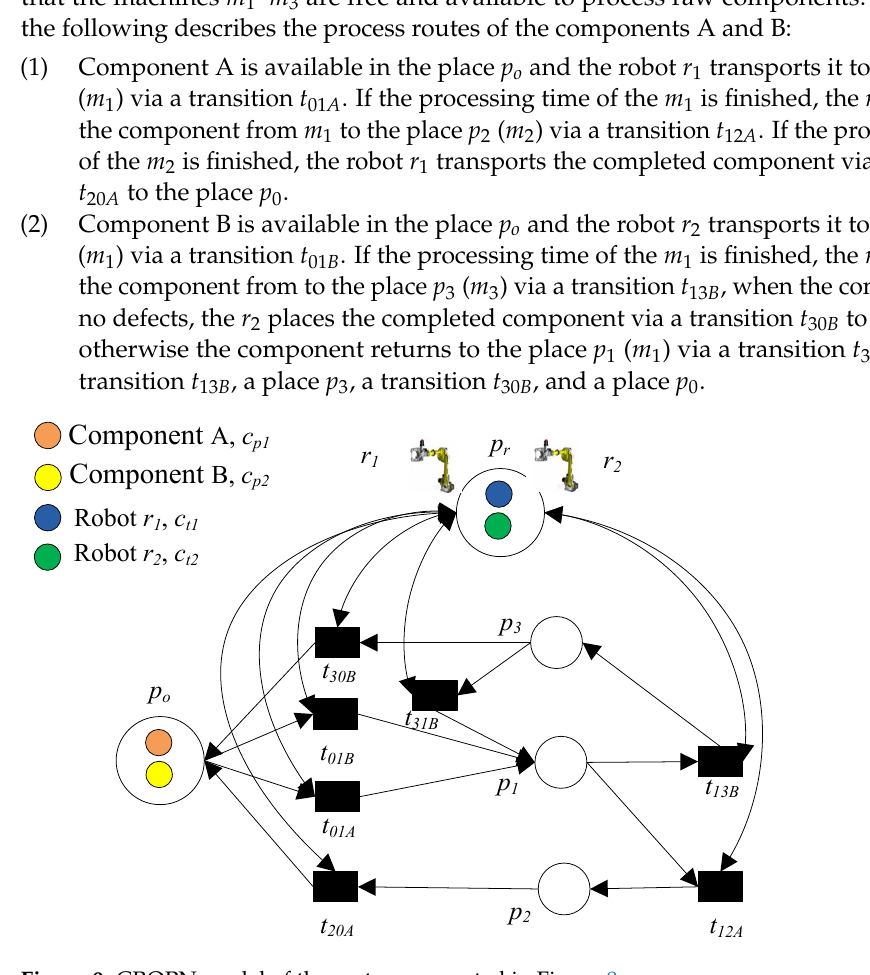
Figure 9. CROPN model of the system presented in Figure 8.